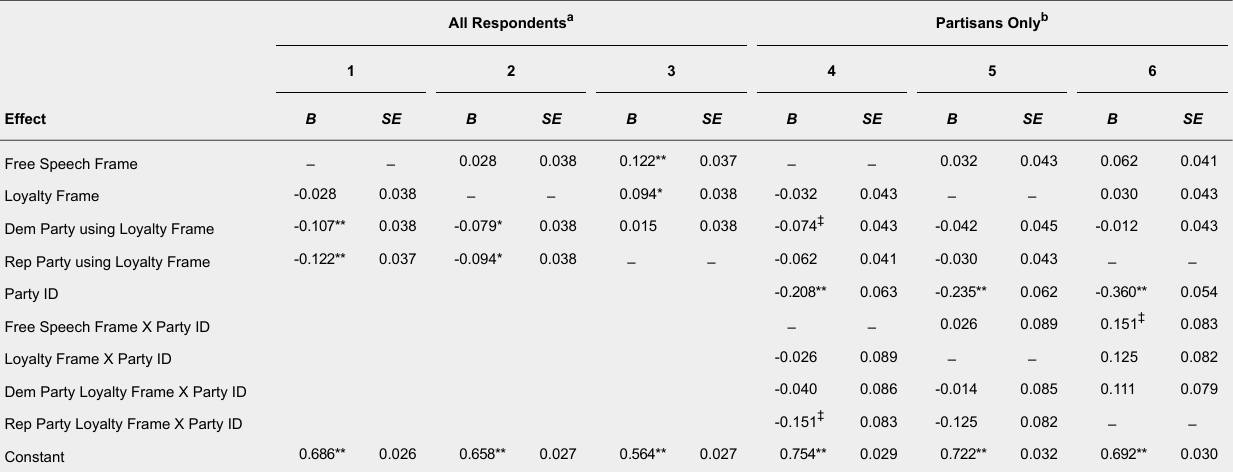
Experimental Treatment Effects for Flag Burning (Study